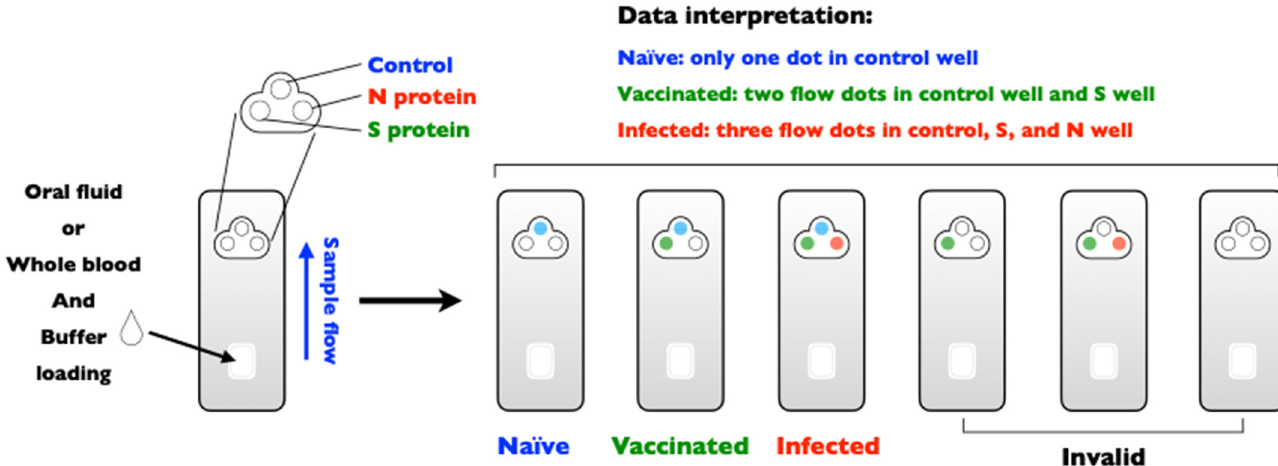
Figure 2. DIVA strategy for SARS-CoV-2 serological testing. The usage of a DIVA assay kit to differential naïve, vaccinated, and/or infected, with invalid results included.